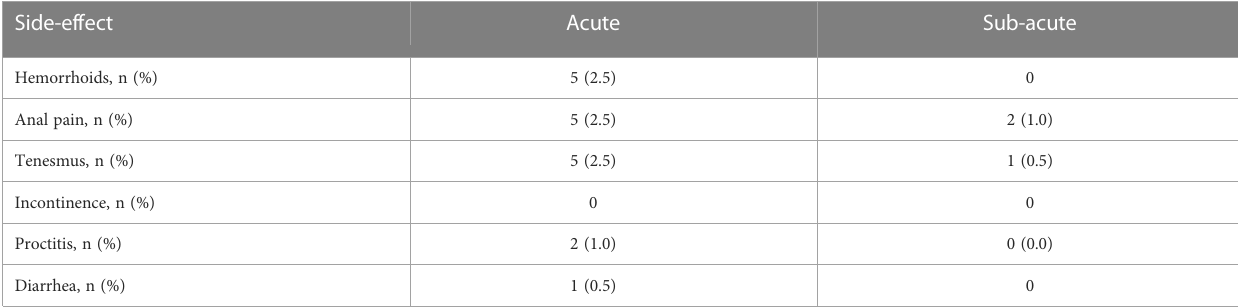
TABLE 3 Acute and subacute gastrointestinal